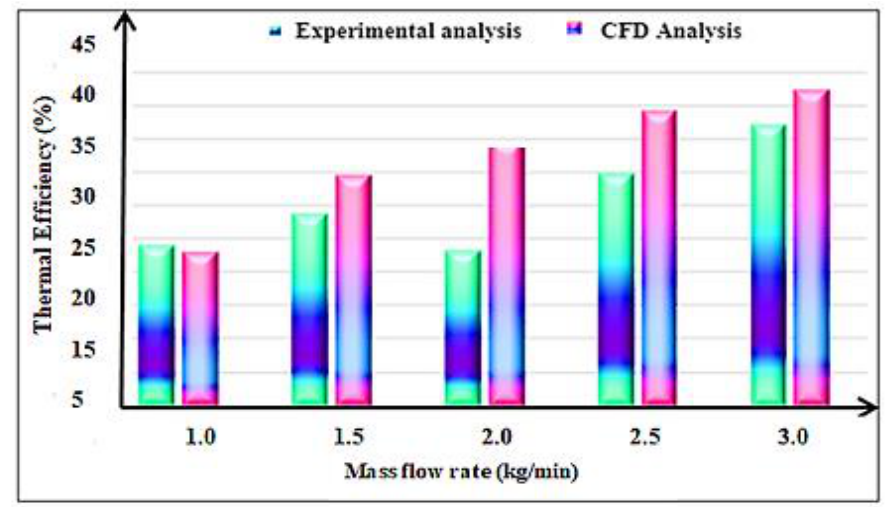
Figure 6. Evaluation of the thermal Figure 6 . Evaluation of the thermal efficiency. Figure 6 . Evaluation of the thermal efficiency.